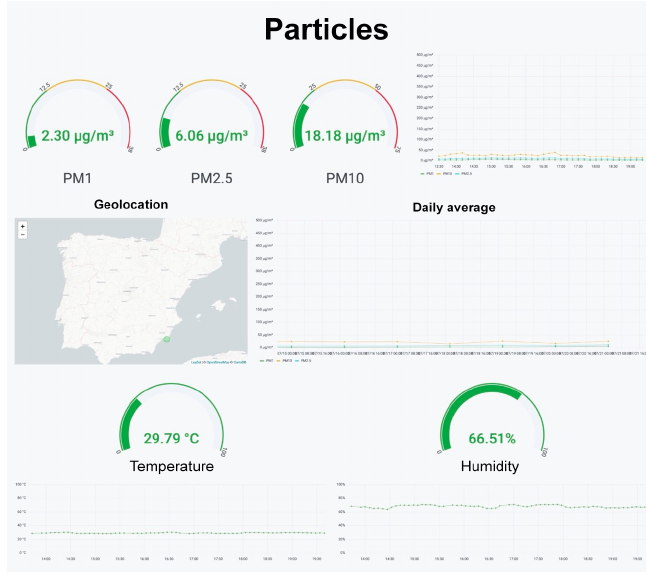
Figure 9. Visualization panel for the particulate matter concentrations in the